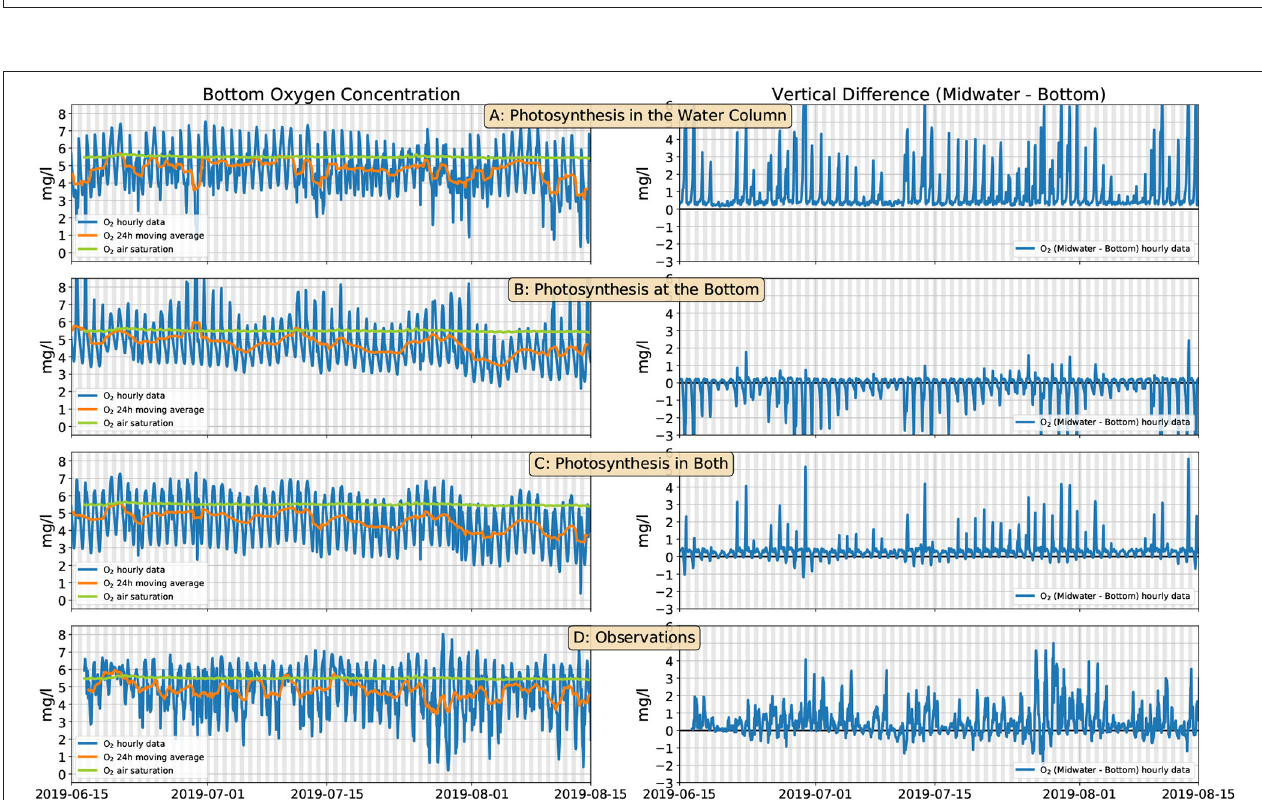
FIGURE 5 | Modeled (section 2.4) and observed bottom O 2 concentration (left panels, blue line) and differences between the midwater and bottom O 2 sensors (right panels, blue line). Orange lines show the daily moving average of the O 2 concentration; green lines are the air O 2 saturation (same in all panels). (A) O 2 is produced by phytoplankton in the water column; (B) O 2 is produced by corals at the bottom; (C) O 2 is produced by both phytoplankton and corals; (D) observations. The grays shaded bands span the 6 p.m. to 6 a.m. interval.